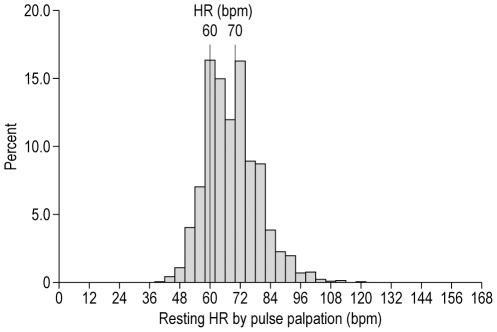
HR distribution in stable CAD patients.